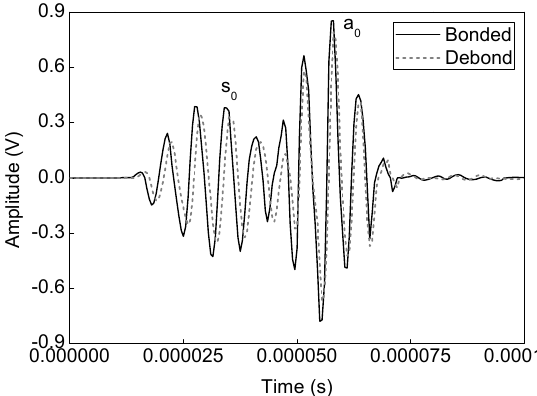
Figure 9. A typical comparison of bonded and debond influenced experimental analysis signals.